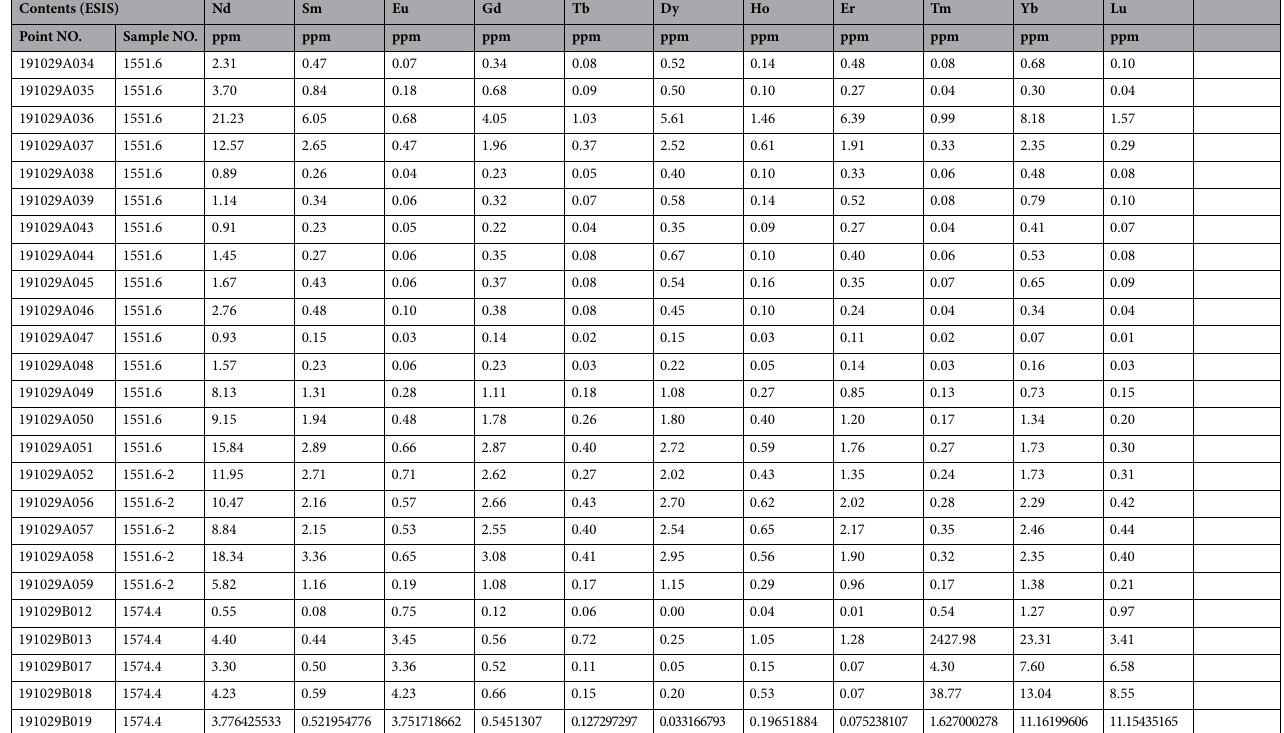
Table 2. Trace elements. We completed a total of 39 experiments on sample 1551.6, 5 experiments on sample 1551.6–2, and 5 experiments on sample